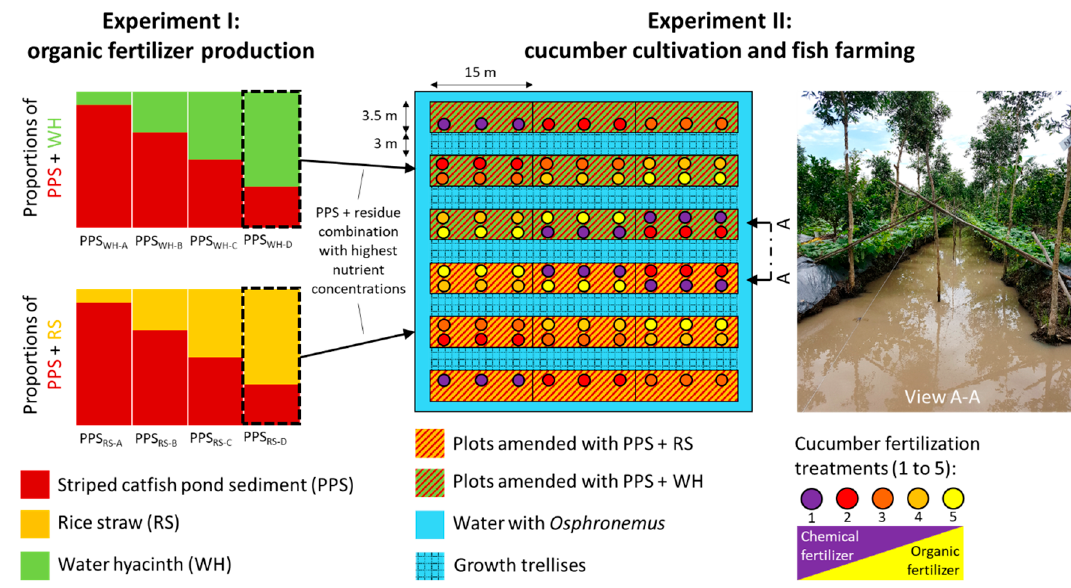
Figure 3. Schematic of the organic fertilizer production in experiment one (left); and layout of the integrated cucumber–fish cultivation with the organic–chemical fertilizer combinations in experiment two (right). In the latter, three replicate plots were amended with different levels of fish pond sediments and water hyacinth (WH, green background) or rice straw (RS, orange background). The organic fertilizer levels are indicated by colored circles (increasing organic fertilizer amount from violet to yellow); note that circles do not indicate individual plants, which were planted at a higher density (40–45 cm apart). View A-A shows a canal with growth trellises.